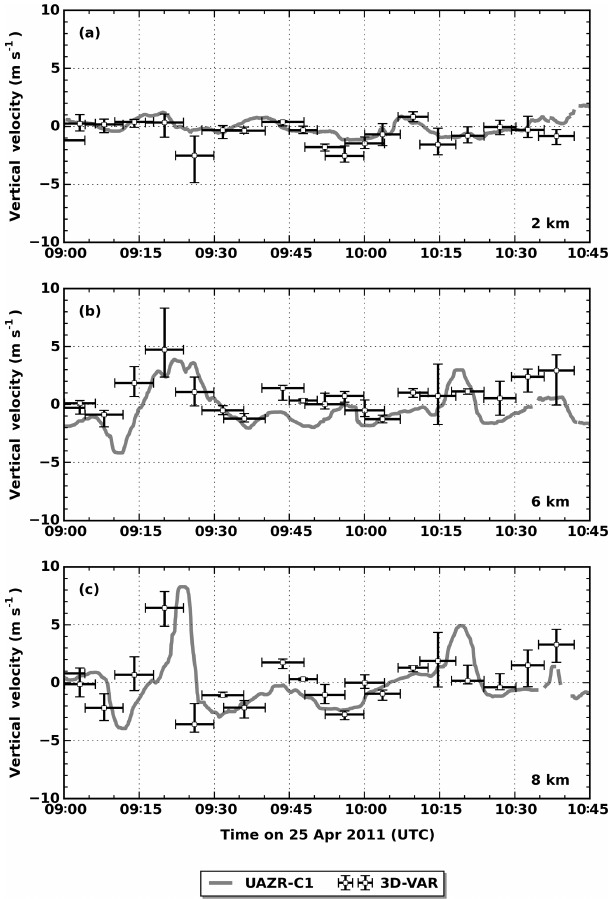
Figure 9. Vertical air motion time series on 25 April 2011 at three characteristic heights: (a) 2km, (b) 6km, and (c) 8kma.g.l. 3DVAR error bars indicate the full range of vertical velocities within R s and the 3DVAR valid time. UAZR-C1 retrievals have been filtered using a 61 × 7 time–height median filter.